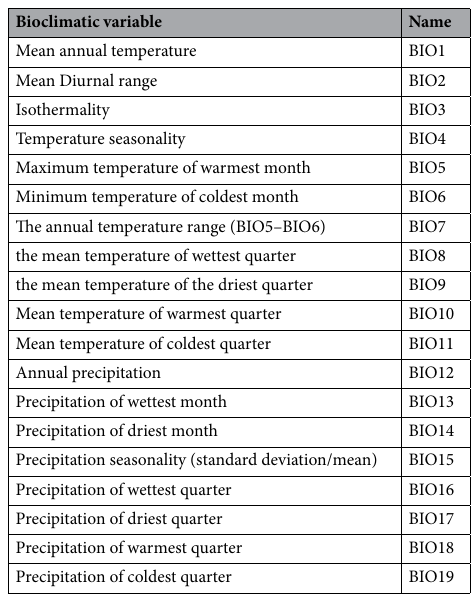
Table 1. Nineteen bioclimatic variables that were used to model the suitable habitats for the studied species in the present